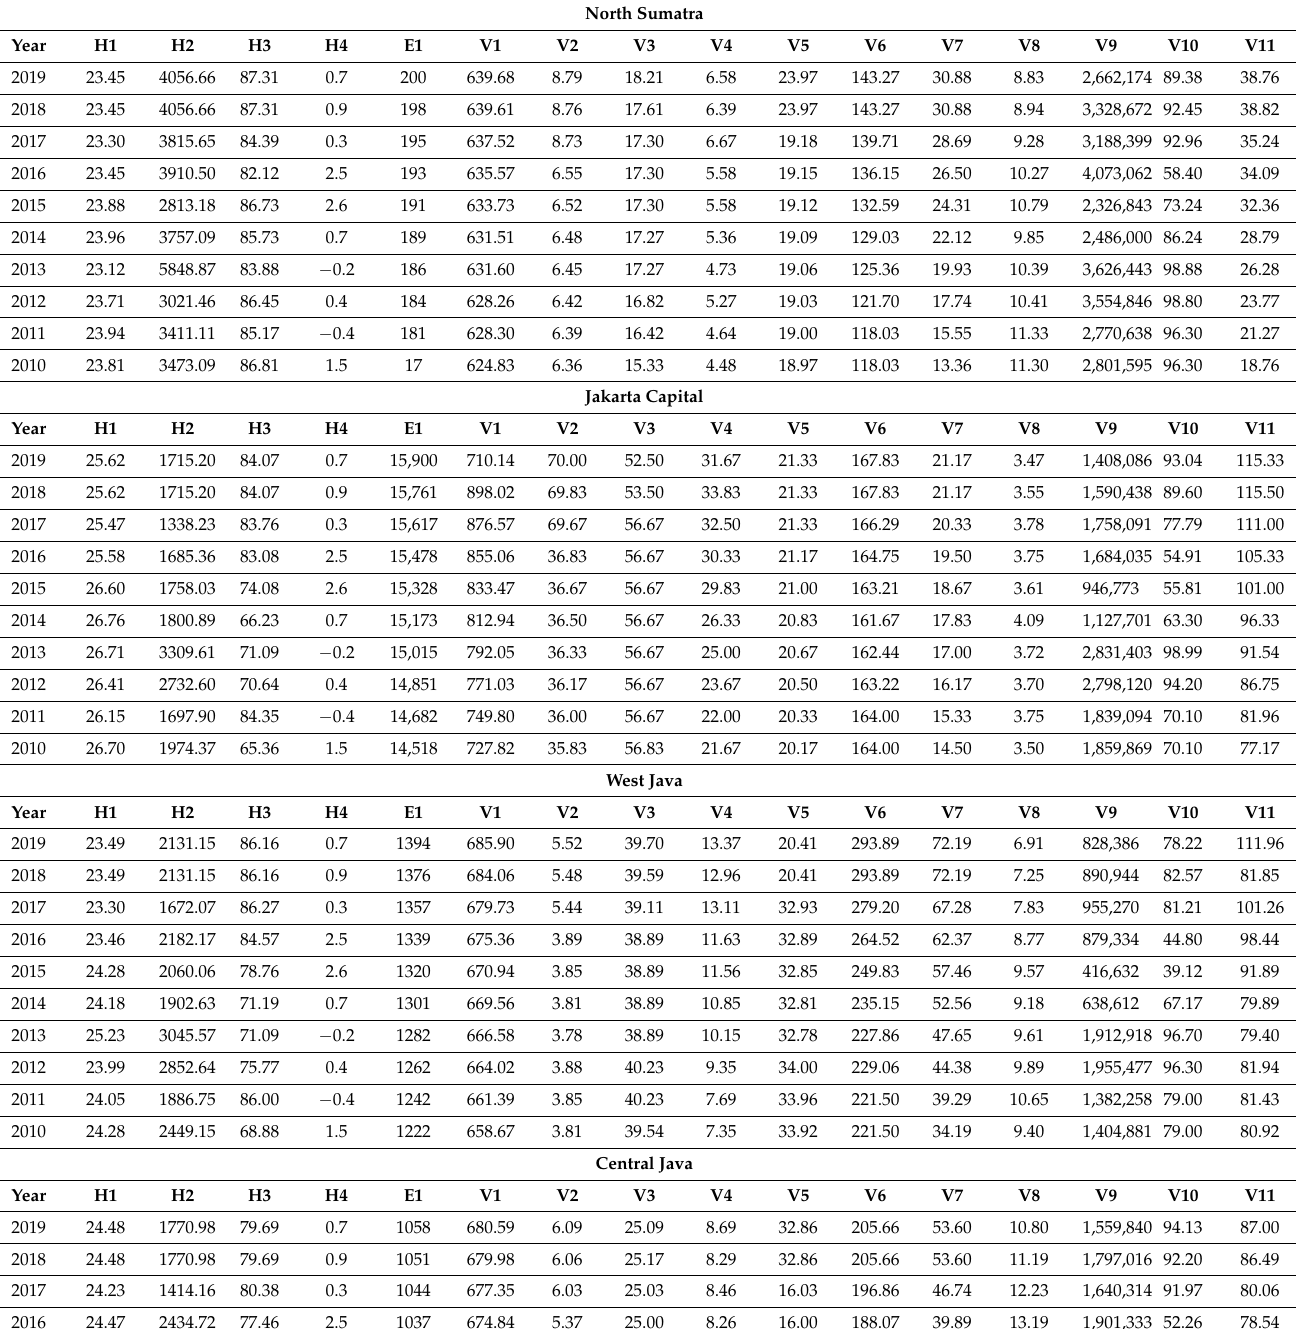
Table A1. Data collection of the impact chain’s